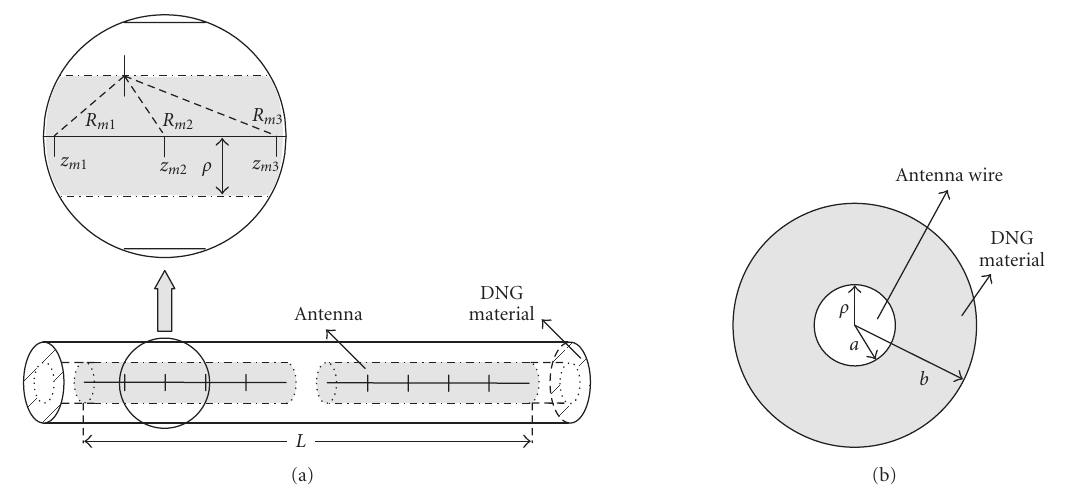
Figure 1: (a) Dipole antenna loaded with a DNG material; (b) cross-sectional view.